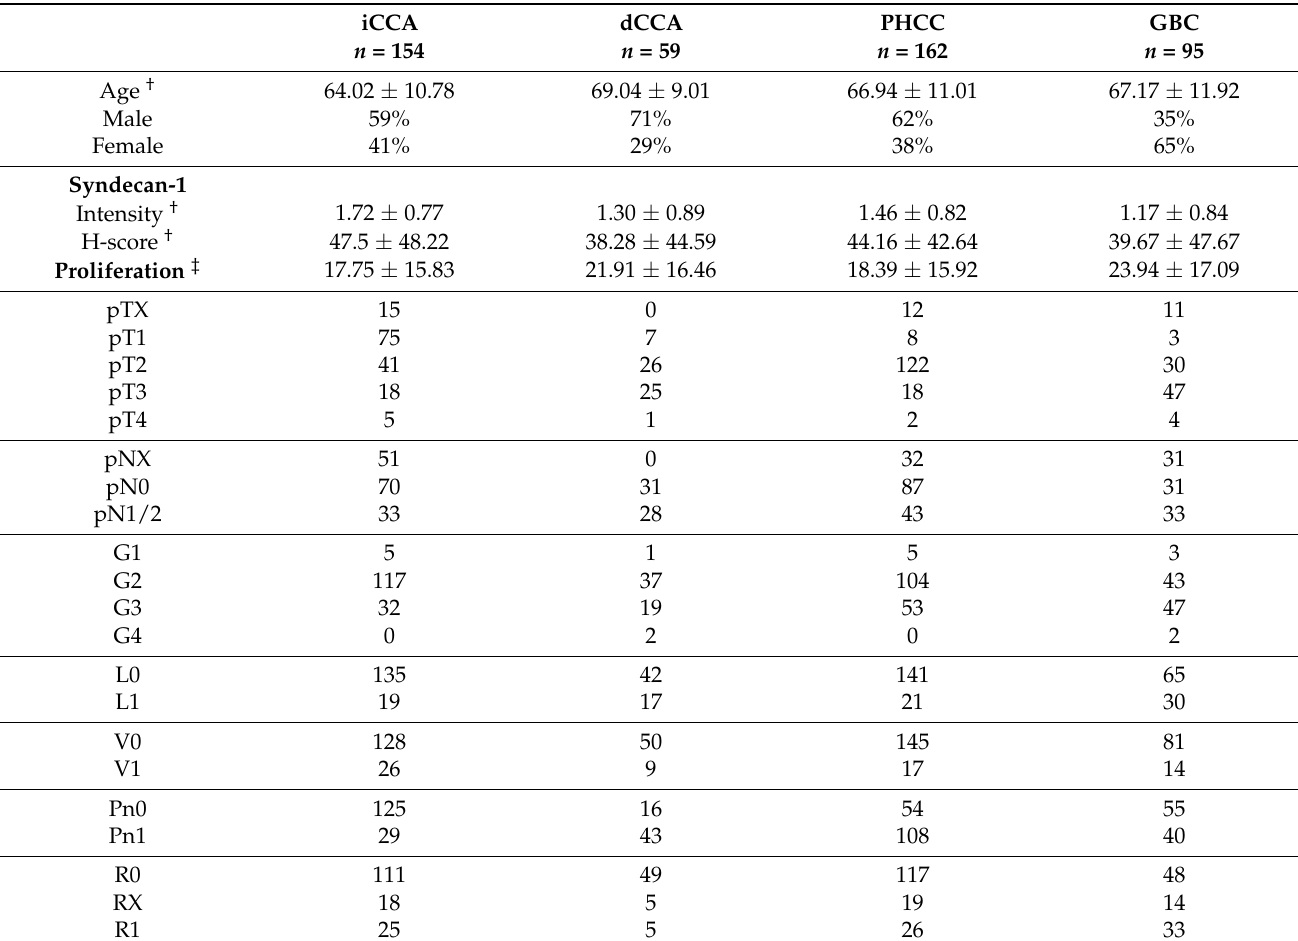
Table 1. Patient